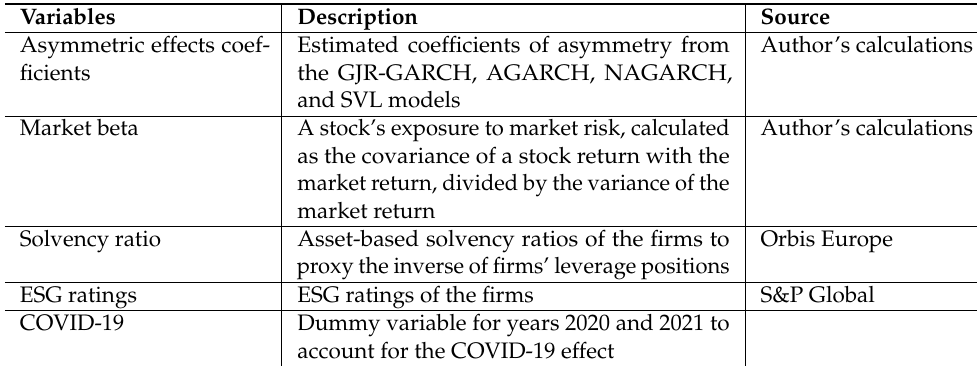
Table 1. Short description of the